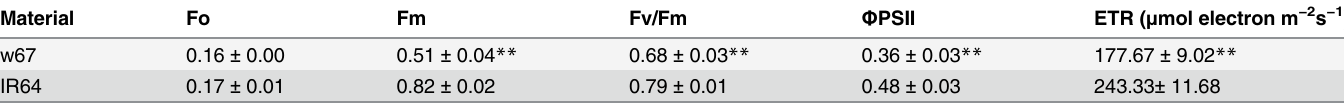
photochemical quantum yield of PSII. The means from three measurements were used for analysis.